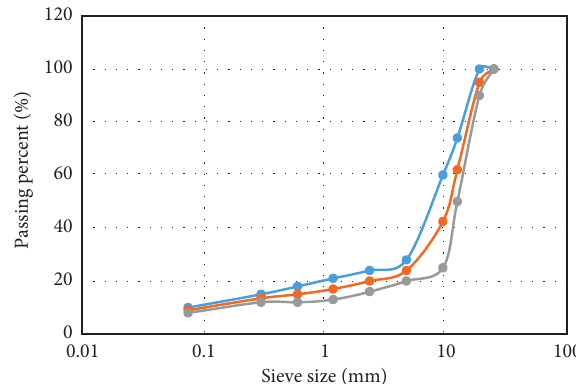
Figure 1: The aggregate grading applied in this